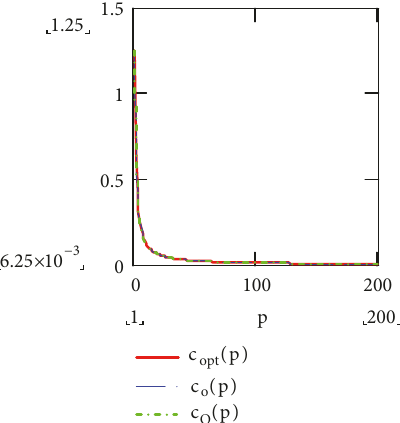
Figure 1: Free function variations for the traffic flow in comparison with the extremal solution (optimal function).